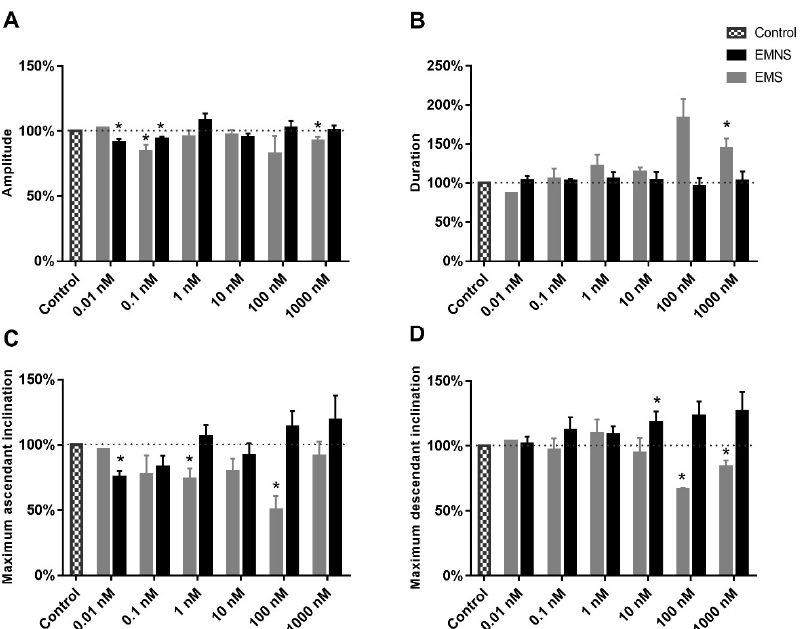
Figure 5. Effect of melatonin on the amplitude ( A ), duration ( B ), maximum ascendant inclination ( C ), and maximum descendant inclination ( D ) of N inf excitability melatonin sensitive (EMS) and excitability melatonin not sensitive (EMNS) cells. These data, expressed in normalized values, are presented as means ± SEM and absolute control values for these parameters are found in Table 1. The number of experiments of N inf EMS neurons at concentrations of 0.01, 0.1, 1.0, 10.0, 100.0, and 1000.0 nM were 1, 4, 6, 10, 3, and, 10, respectively. The number of experiments of N inf EMNS neurons at concentrations of 0.01, 0.1, 1.0, 10.0, 100.0, and 1000.0 nM were 13, 7, 12, 15, 10, and 18, respectively. The symbol * indicates statistically significant difference as compared to control ( p < 0.05, paired Student’s t -test).